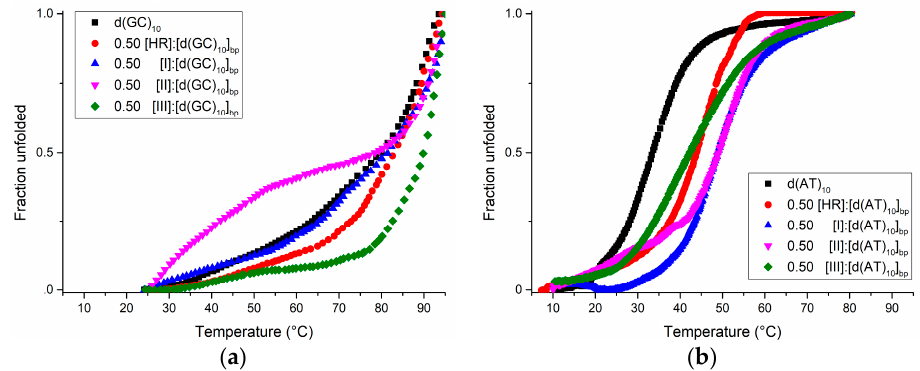
Figure 4. Normalised UV thermal denaturation curves of d(GC) 10 ( a ) and d(AT) 10 ( b ) in the absence and presence of ligands at 0.50 [ligand]:[DNA] bp ratio followed at 260 nm.